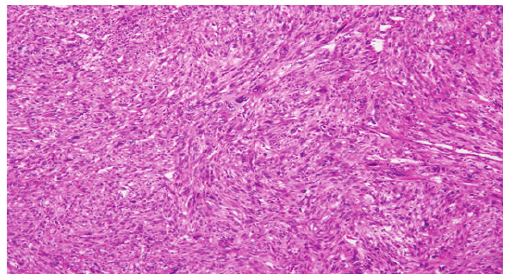
Figure 3: Spindly tumor cells with eosinophilic cytoplasm, blunt ended nuclei with bizarre nucleus. H&E × 40.